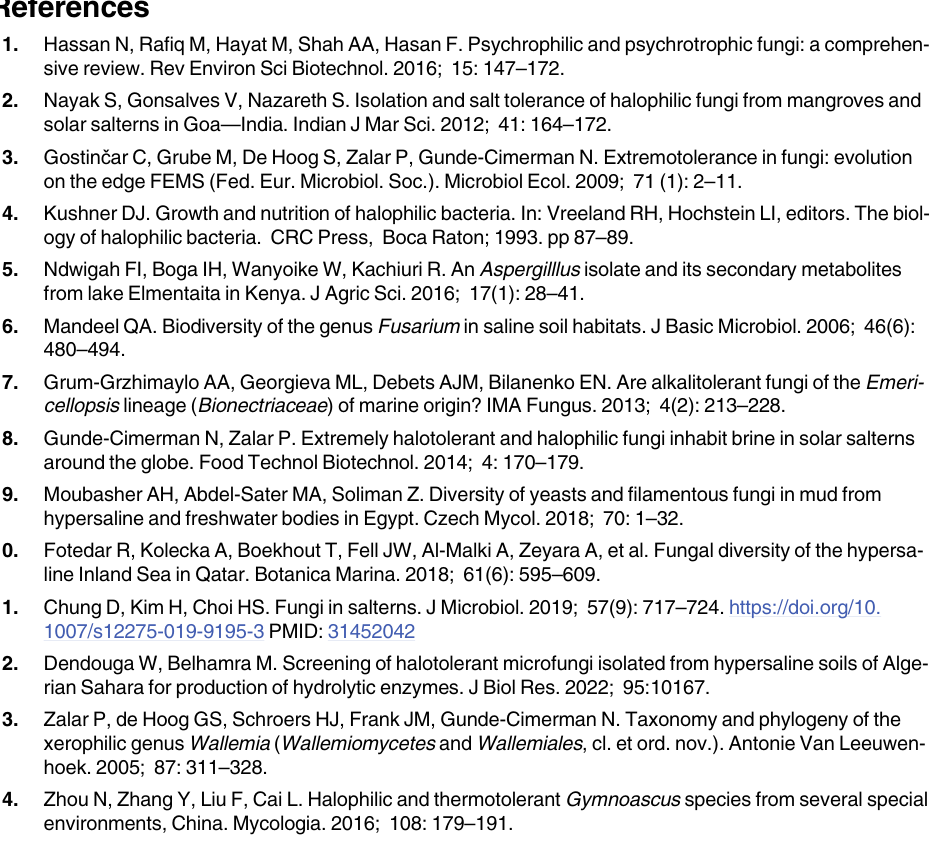
S1 Table. Antimicrobial activity of fungi isolated from saltern farms in Pattani Province. Antimicrobial activity of ethanolic extracts of the culture broths and mycelia of eight active isolates using the agar well diffusion